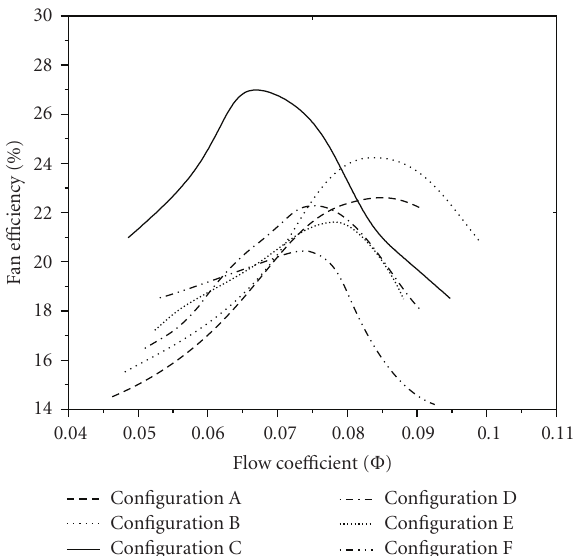
Figure 4: Performance of centrifugal fan (e ffi ciency versus flow coe ffi cient).